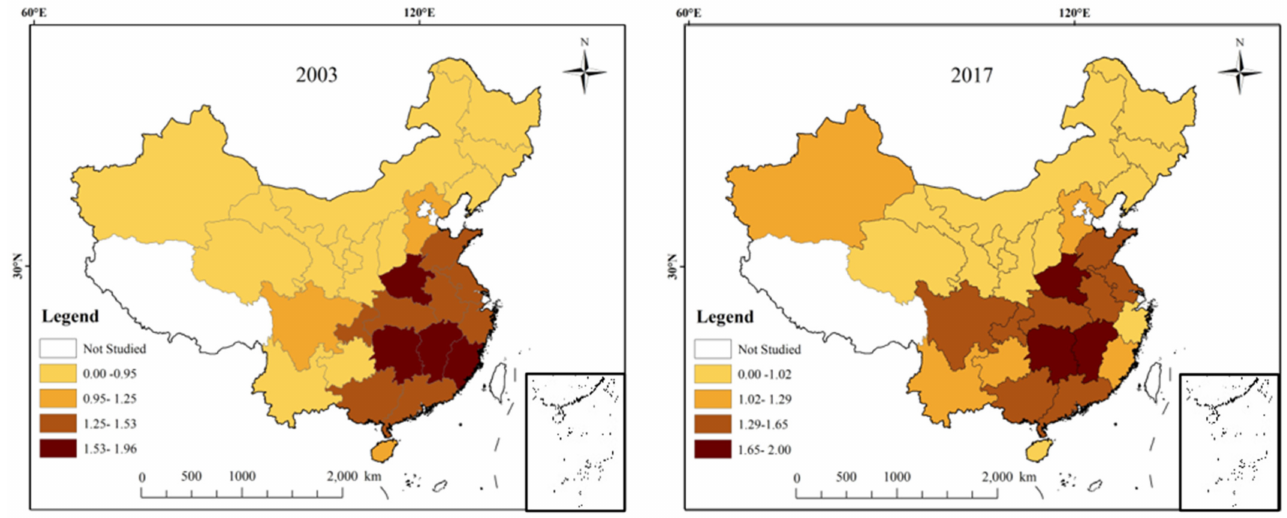
Figure 2. The evaluation results of RMT in 2003 and